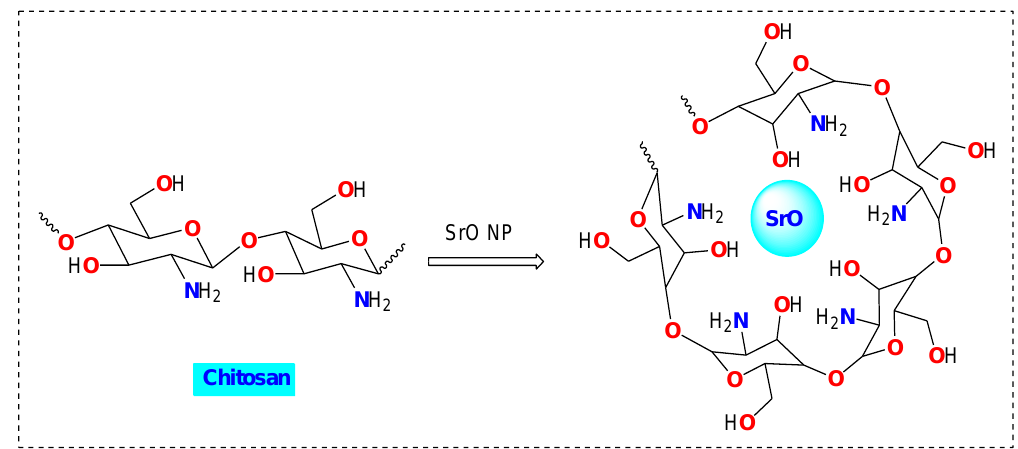
Figure 1. The chitosan-SrO nanocomposite in a simplified viewpoint (Lister, UK).